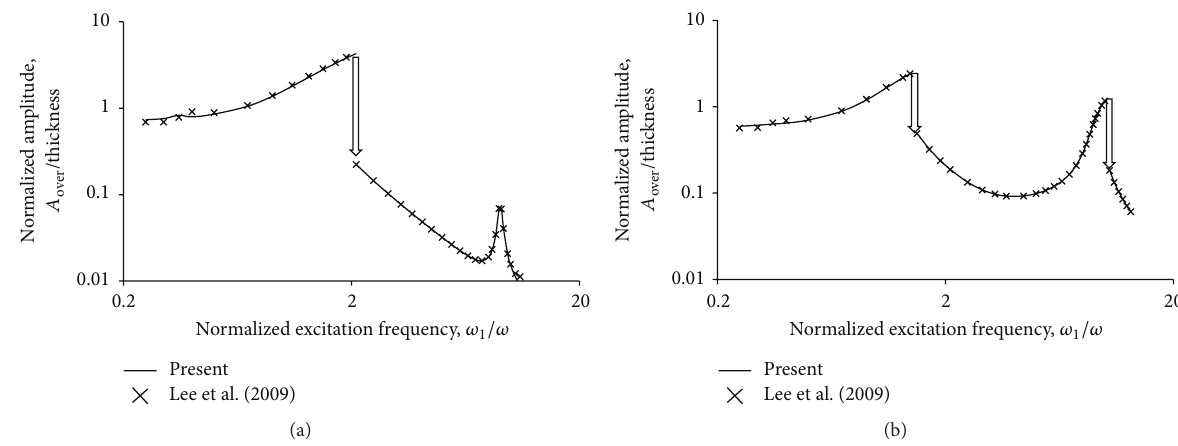
Figure 1: (a) Comparison between the results from the proposed and numerical integration methods, 𝐹 = 7.5𝜌 𝐴 𝑔 sin (𝜔𝑡) . (b) Comparison between the results from the proposed and numerical integration methods, 𝐹 = 75(0.1 sin ((𝜋/𝐿)𝑥) + 0.9 sin ((3𝜋/𝐿)𝑥))𝜌 𝐴 𝑔 sin (𝜔𝑡) .